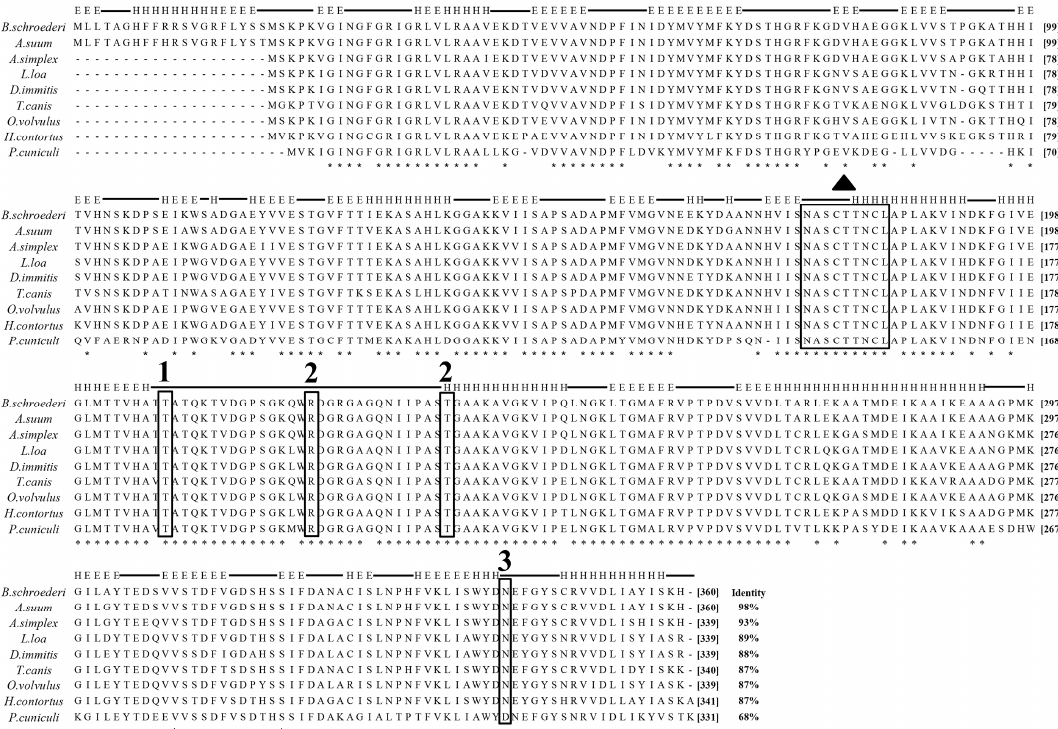
Figure 1. Multiple sequence alignment of B. schroederi GAPDH with homologues from other species. Ascaris suum GAPDH (ERG79426.1), Anisakis simplex GAPDH (AIT71762.1), Loa loa GAPDH (XP_020305933.1), Dirofilaria immitis GAPDH (AFL46382.1), Toxocara canis GAPDH (KHN89029.1) , Onchocerca volvulus GAPDH (AAB52599.1), Haemonchus contortus GAPDH (ADI46817.1), Psoroptes cuniculi GAPDH (unpublished). Amino acid residues in marked boxes are (1) GAP phosphate binding site, (2) inorganic phosphate binding sites, (3) NAD+ binding site, whereas ( ▲ ) indicates enzymatic binding site.